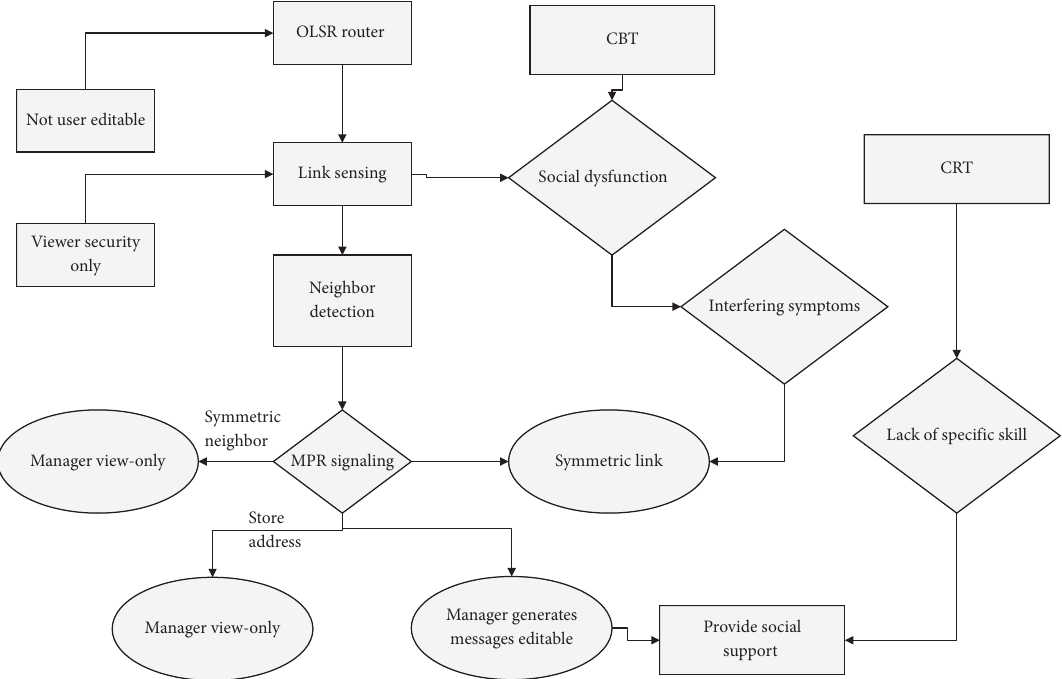
Figure 3: Value chain combined with a virtual network mapping